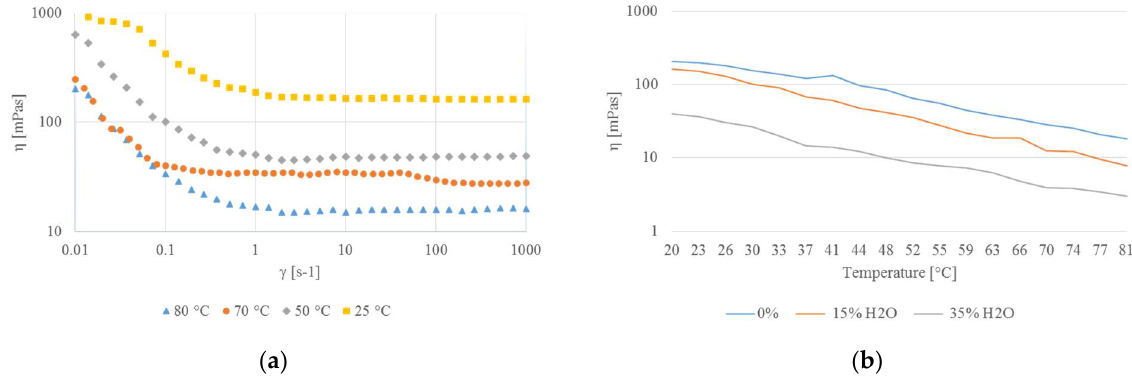
Figure 3. ( a ) Viscosity (η) versus shear rate (γ) change at different temperatures (blue 80 °C, orange 70 °C, grey 50 °C, yellow 25 °C); ( b ) viscosity (η) versus temperature change for different water contents (% v / v ) at g = 1 [s −1 ].